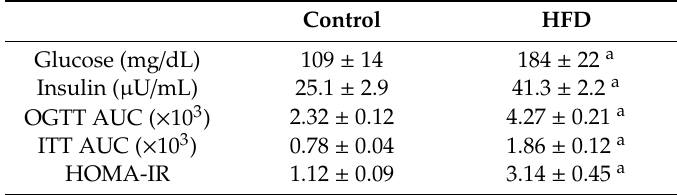
Table 1. Glucose metabolism parameters in the plasma of mice fed a control and high-fat